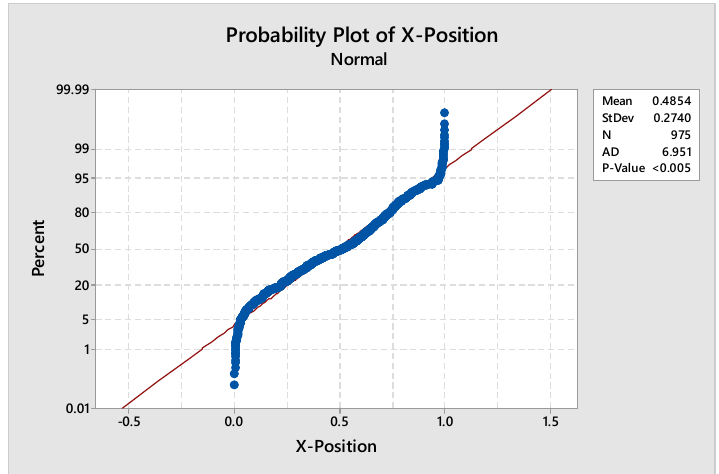
Figure 12 . Probability plot for X Position. Figure 12. Probability plot for X